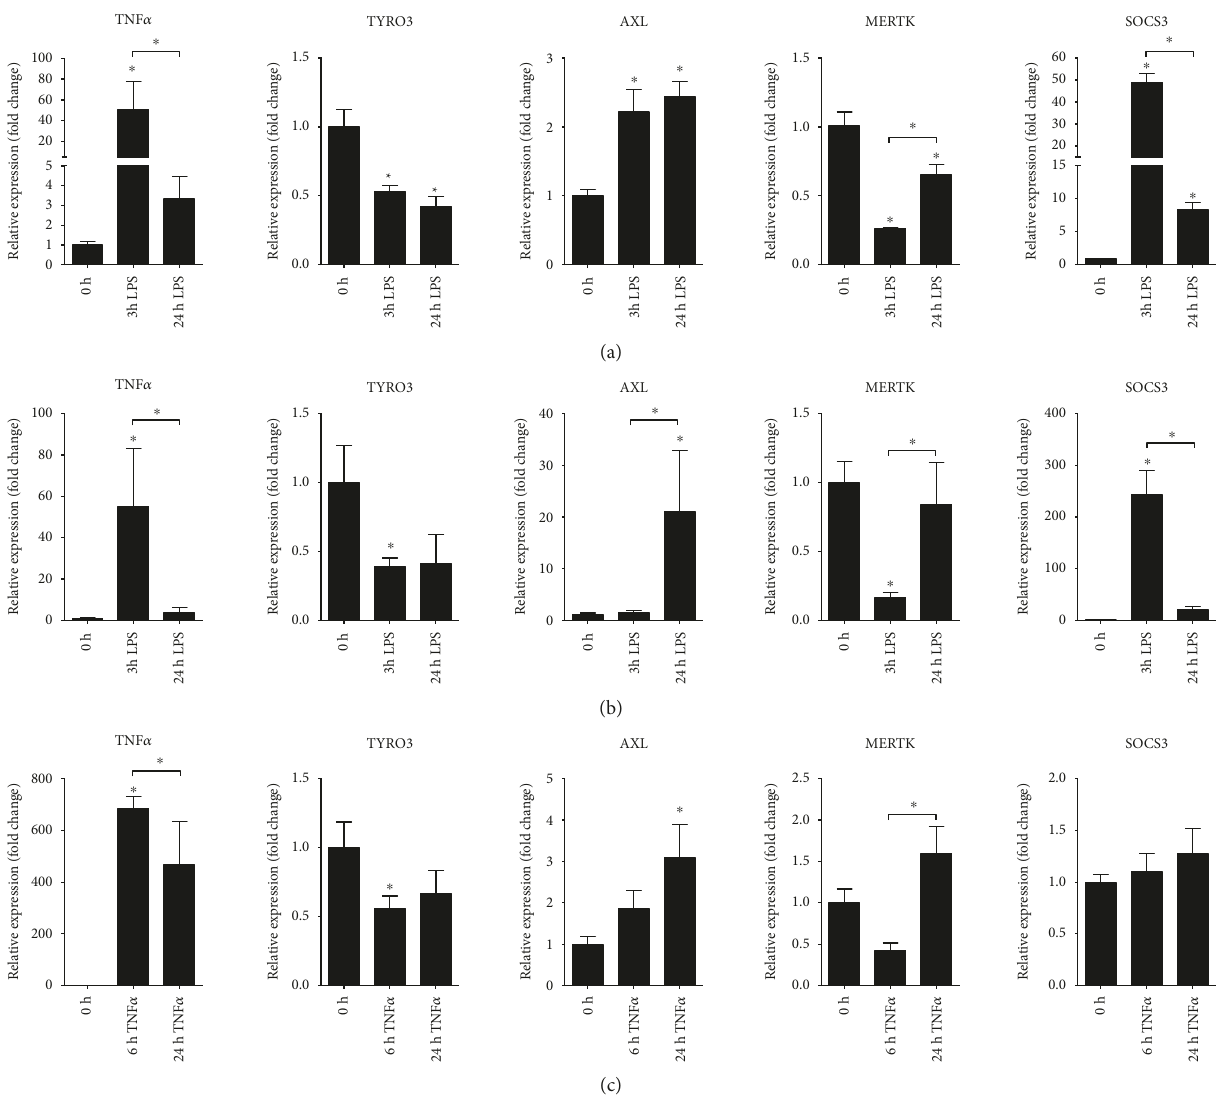
Figure 4: Distinct expression of TAM receptors in LPS triggered THP-1 and TNF α triggered HT-29 cells. The relative gene expression of the proin fl ammatory molecule TNF α , TAM receptors TYRO3 , AXL , and MERTK , and the suppressor of cytokine signalling SOCS-3 in (a) inactivated LPS-stimulated THP-1, (b) PMA-activated LPS-stimulated THP-1, and (c) TNF α -stimulated HT-29 cells. Data are presented as the mean ± SEM; n = 3 ; ∗ p < 0 05